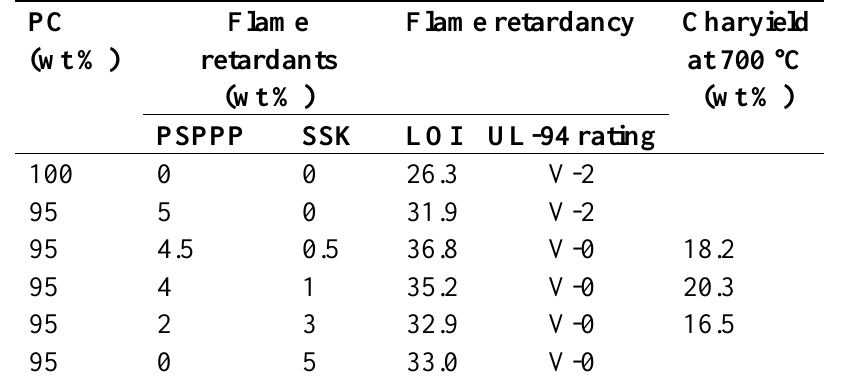
Table 5. Flame retardancy of PC/PSPPP/SSK mixtures with different contents of the flame retardants